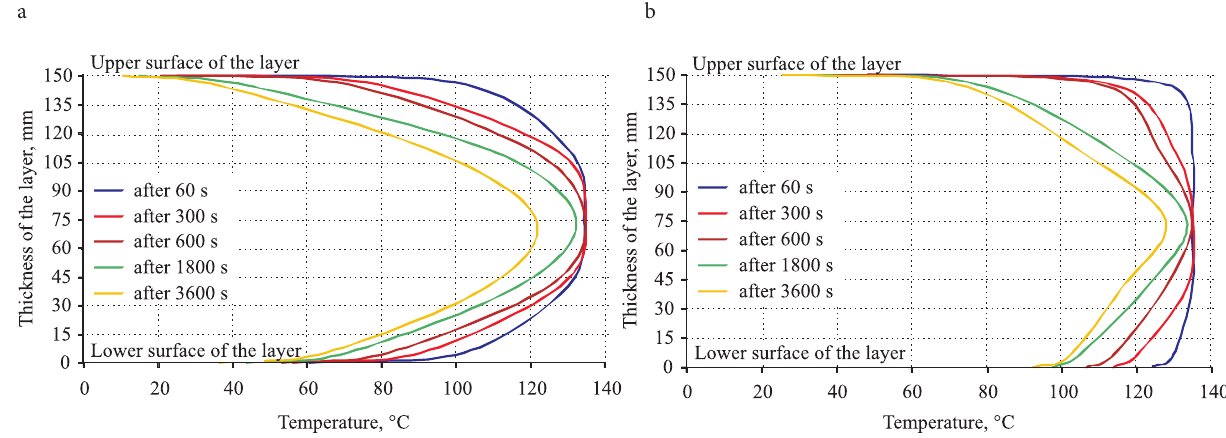
Fig. 6. Theoretical changes in the temperature in time in HMA layer 15 cm thick in the air temperature: a – 0 °C and with the wind of 8 m/s velocity (with water staying in the foundation); b – 20 °C with the wind of 0 m/s (with no water staying in